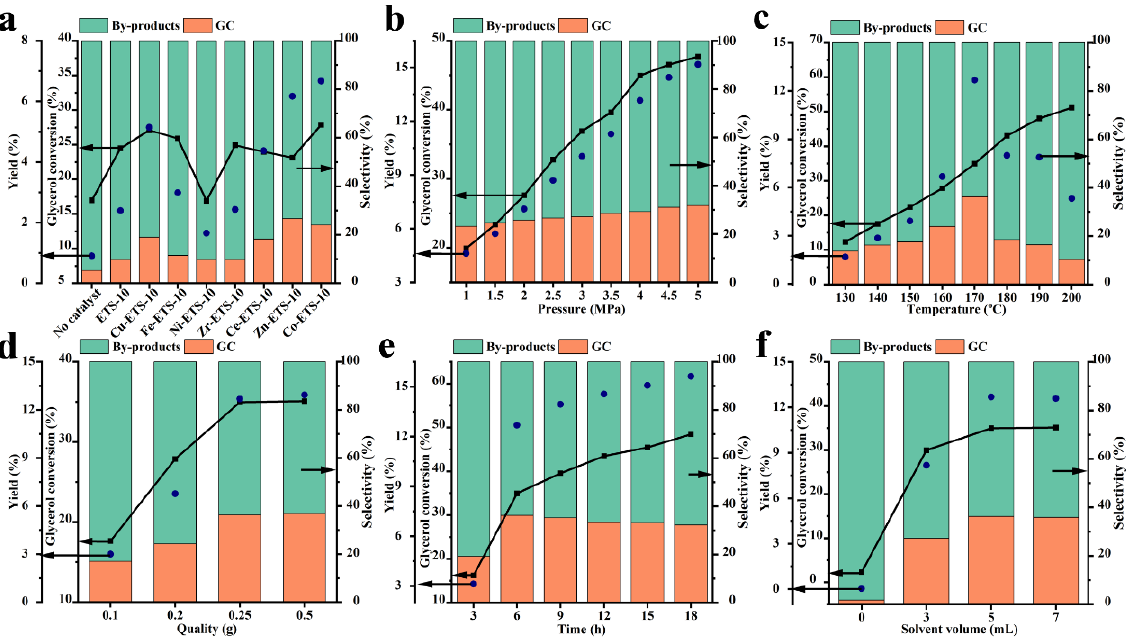
Figure 4. ( a ) the activity of the different catalysts for converting CO 2 and glycerol into GC, and the catalytic performance of Co/ETS-10 for GC formation as a function of ( b ) pressure, ( c ) temperature, ( d ) catalyst quality, ( e ) reaction time, and ( f ) solvent volume (reaction conditions: 170 °C, 4 MPa, 0.25 g catalyst, 6 h, and 5 g CH 3 CN).